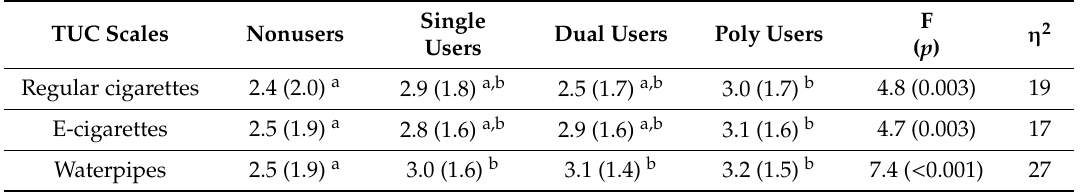
Table 2. Means and standard deviations for the tobacco use cognitions scales (TUCS) by polytobacco status. TUC